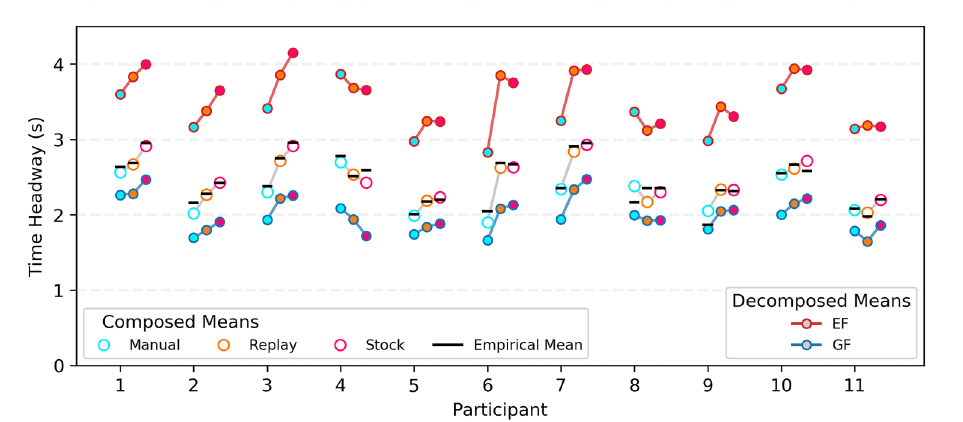
Figure 7. Individual means: Composed means, decomposed means, and empirical means for each participant. Larger circles are the mixture model composed means, coloured for each driving condition (Manual = cyan; Auto-Replay = yellow, Auto-Stock = magenta). Smaller circles and connected lines show the decomposed means for GF (blue) and EF (red). Black horizontal lines are the empirical means for that driving